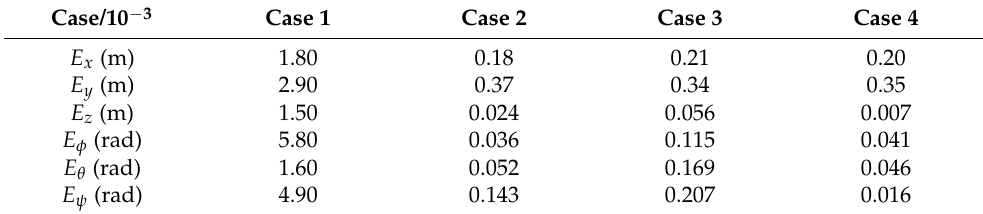
Table 5. Average position and orientation errors of the end-effector under four cases from 10 s to 50 s.